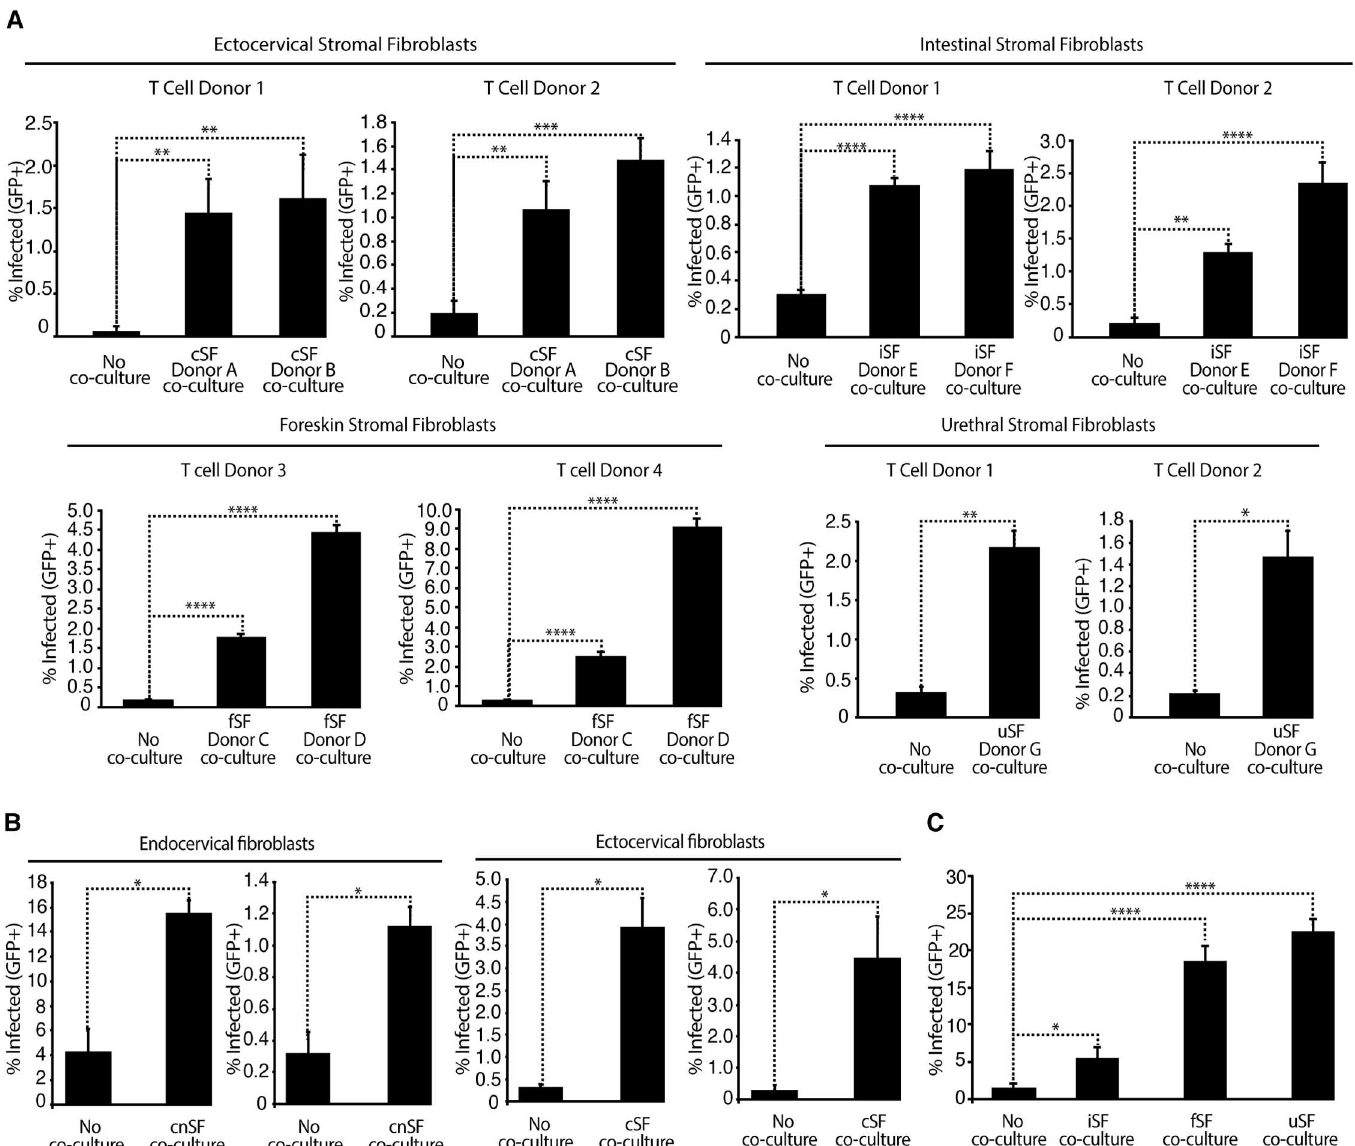
Fig 6. Fibroblasts from the ectocervix, intestine, foreskin, and male urethra enhance HIV infection of CD4+ T cells. (A) PHA/IL2-activated CD4+ T cells from four donors (labeled1–4) cultured in the absenceor presenceof the indicatedfibroblastswere infected with NLENG1I and monitoredfor infection levels 3 d later by flow cytometry. Results are gated on live, singletCD3+CD8-cells. * p < 0.05, ** p < 0.01relativeto no co-culture in a group-wise comparison (one-way analysisof variancewith a Bonferroni posttest). (B) PHA/IL2-activated CD4+ T cells were infected with BaL GFP in the absenceor presence of cnSF from two different donors ( left ) or cSF from two different donors ( right )and monitored for infection levels 3 d later by flow cytometry. Results are gated on live, singlet CD3+CD8-cells. * p < 0.05by 2-tailed t test. (C) PHA/IL2-activated CD4+ T cells were infected with BaL GFP in the absenceor presenceof iSF, fSF, or uSF and monitoredfor infectionlevels 3 d later by flow cytometry. * p < 0.05, **** p < 0.0001 relative to no co-culture in a group-wise comparison(one-way analysisof variance with a Bonferroni